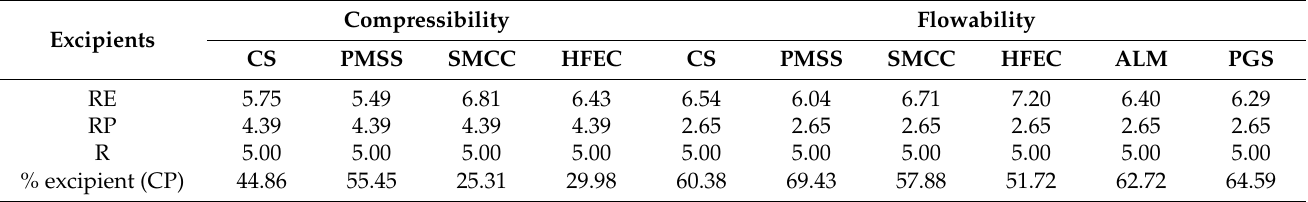
Table 3. Percentage of excipients required to correct paracetamol characteristics in tablet formulations.